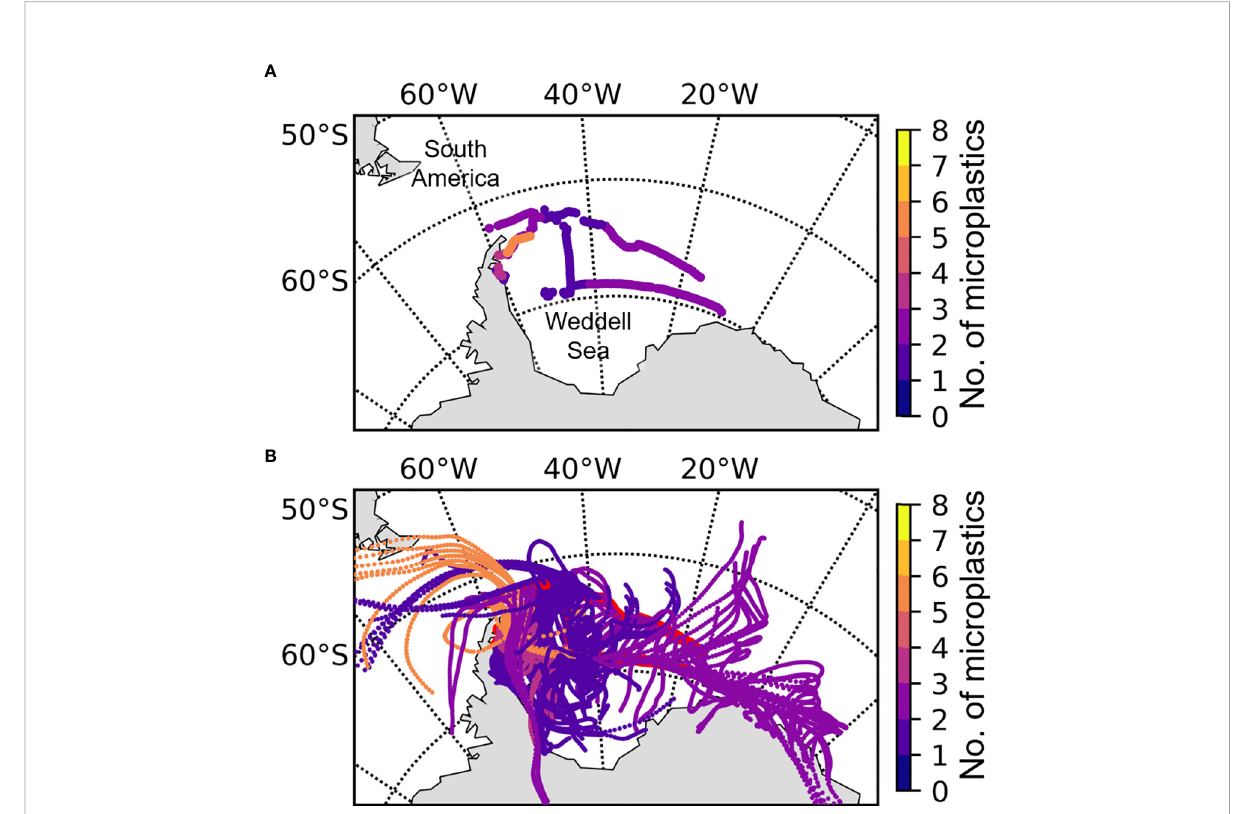
FIGURE 4 Cruise track across the northern edge of the Weddell Sea (A) , overlayed by 72 hr AMBTs (B) computed for each hour of every air sample (the red line highlights the ship ’ s track). Both subplots are colour coded by the number of microplastics recovered from the air